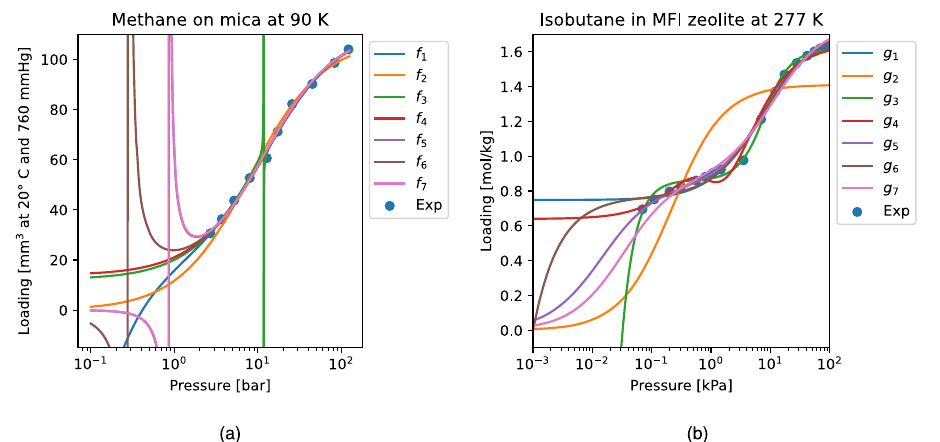
Fig. 5|Symbolicregressionsolutionstotwoadsorptiondatasets. Fig. 5 a refers tothemethaneadsorptiononmicaatatemperatureof90K,whileFig.5 b refersto the isobutane adsorption on silicalite at a temperature of 277 K. f 2 and g 2 are